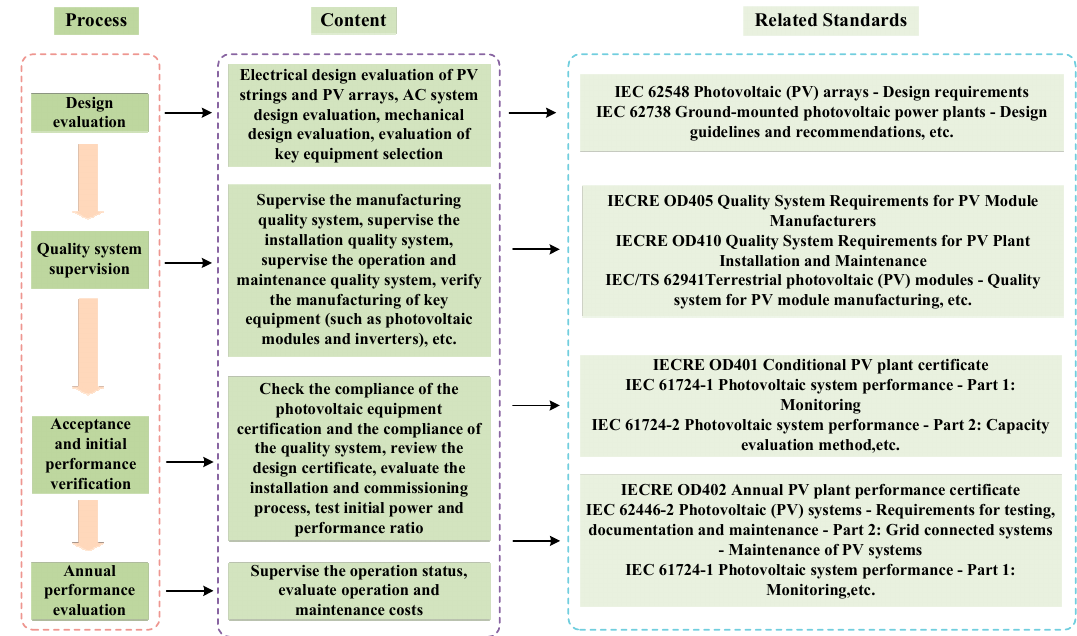
Figure 4. IECRE certification process and requirements.